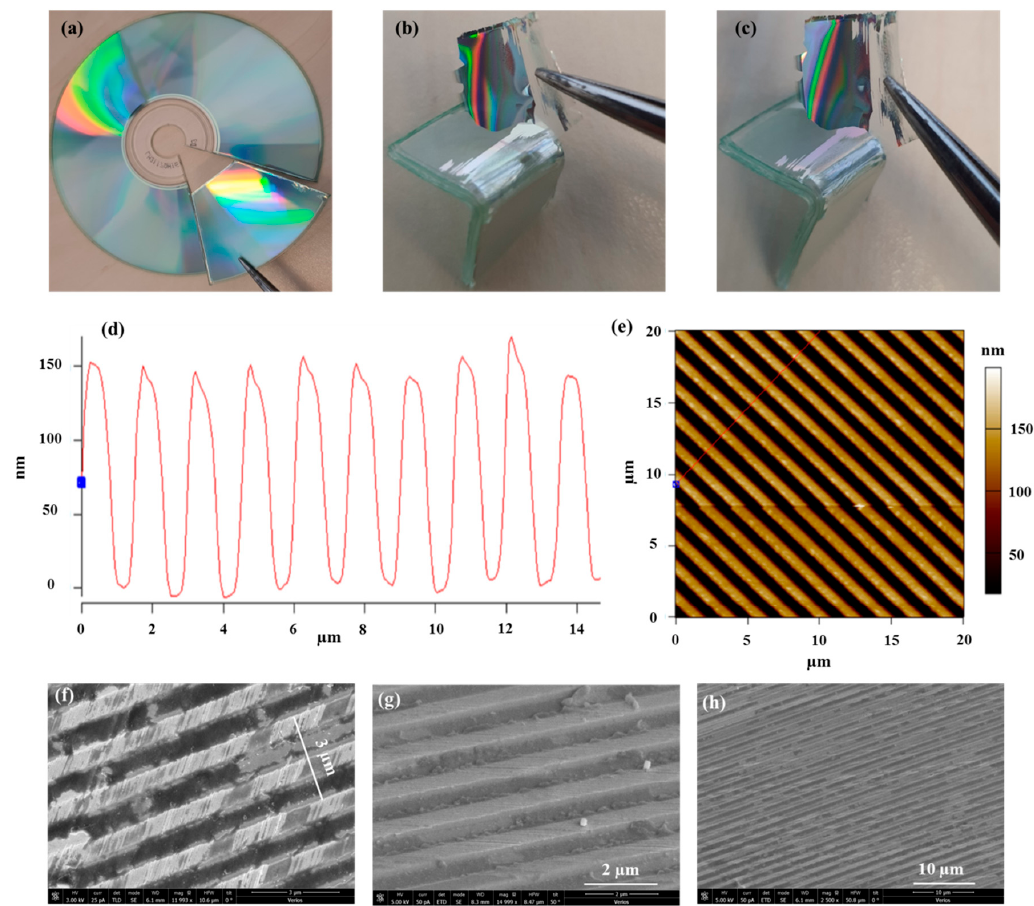
Figure 15. ( a ) The piece cutting from the CD. ( b , c ) The extracted sample at different angles. ( d ) AFM characterization of the prepared sample showing the grating height of ~150 nm. ( e ) AFM characterization of the prepared sample showing the grating period of ~1500 nm. ( f – h ) Different SEM characterization of the prepared sample showing the grating structure.